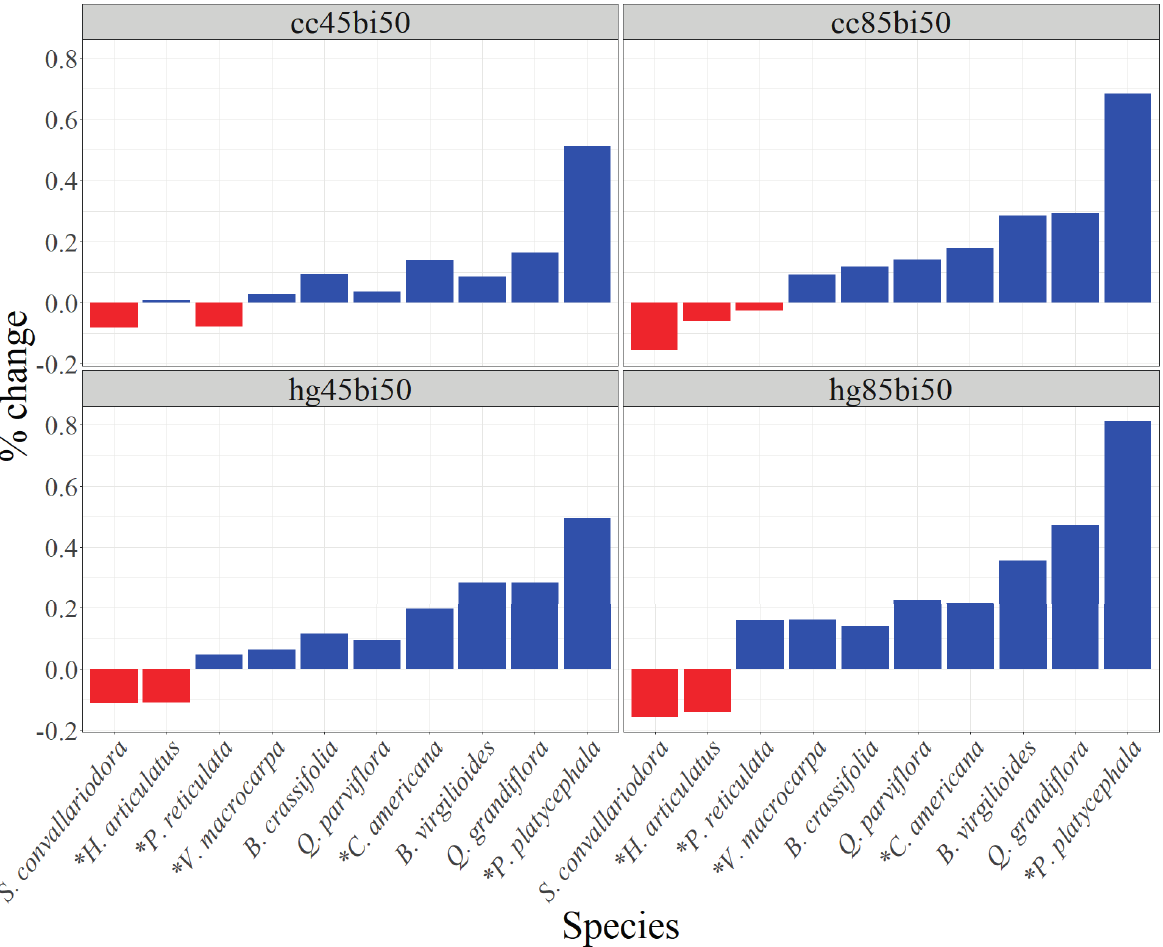
Figure 2. Potential change in the area by species in different scenarios of future climate change (2050; GCMs CC and HG; RCP 4.5 and RCP 8.5). Blue: expansion; red: retraction. * Marginal species typical of the northern